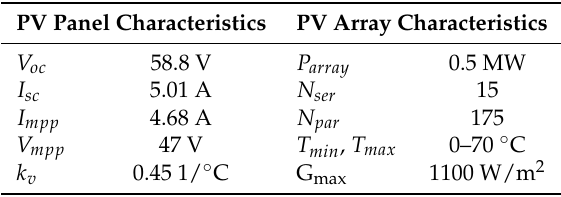
Table 1. PV panel and array